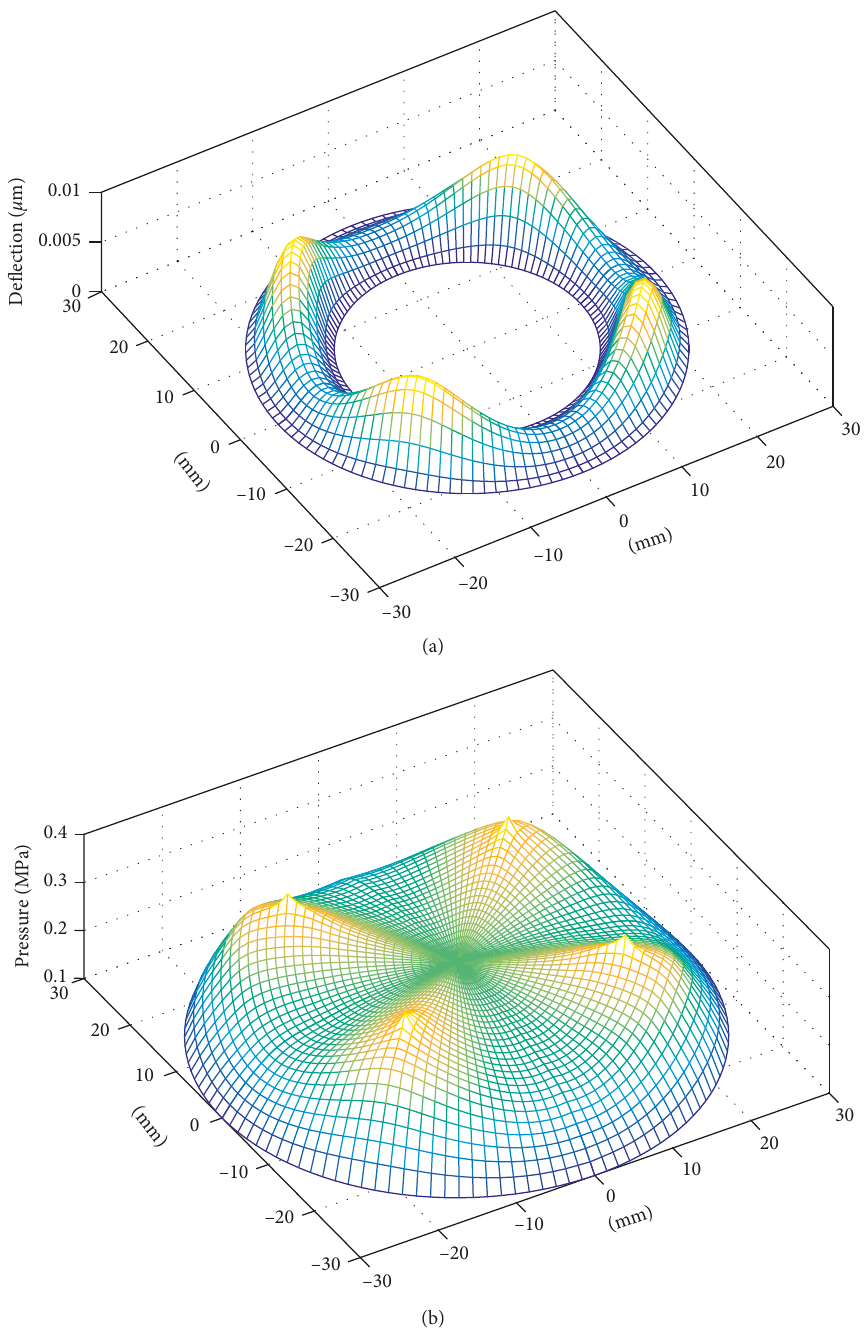
Figure 3: Static characteristics of the aerostatic bearing with EEPG ( h � 8m). (a) Deformation diagram of EEPG. (b) Gas film pressure distribution